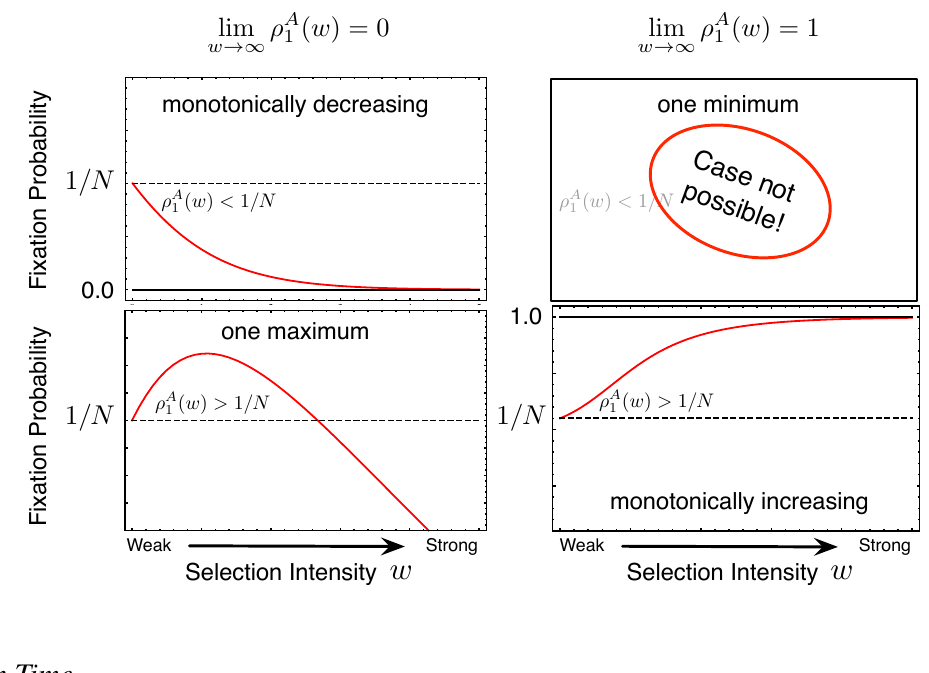
Figure 1. Illustrations of possible shapes of the fixation probability as a function of the selection intensity. Based on Theorem 1, we illustrate the qualitative shape of the fixation probability as a function of the selection intensity, given that the strong and weak selection scenarios are known. Under weak selection, the fixation probability of strategy A can be less than neutral (top row) or greater than neutral (bottom row). Simultaneously, in the limit of strong selection, the fixation probability can approach zero (left column) or unity (right column). We show that the top right case, i.e. , the fixation probability being less than neutrality under weak selection and approaching unity for strong selection, is not possible (Theorem 1). This means that an unfavorable strategy under strong selection can be selected for under weak selection (bottom left), but a favorable strategy under strong selection will never be unfavorable for any intensity of selection (top